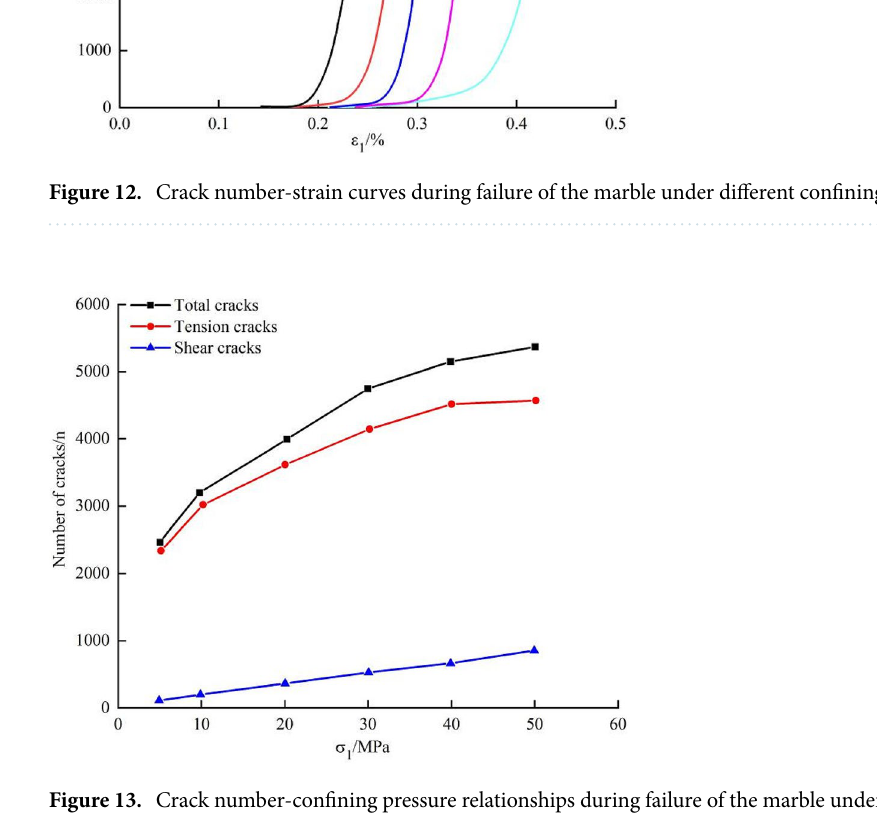
Figure 13. Crack number-confining pressure relationships during failure of the marble under confining- pressure unloading.